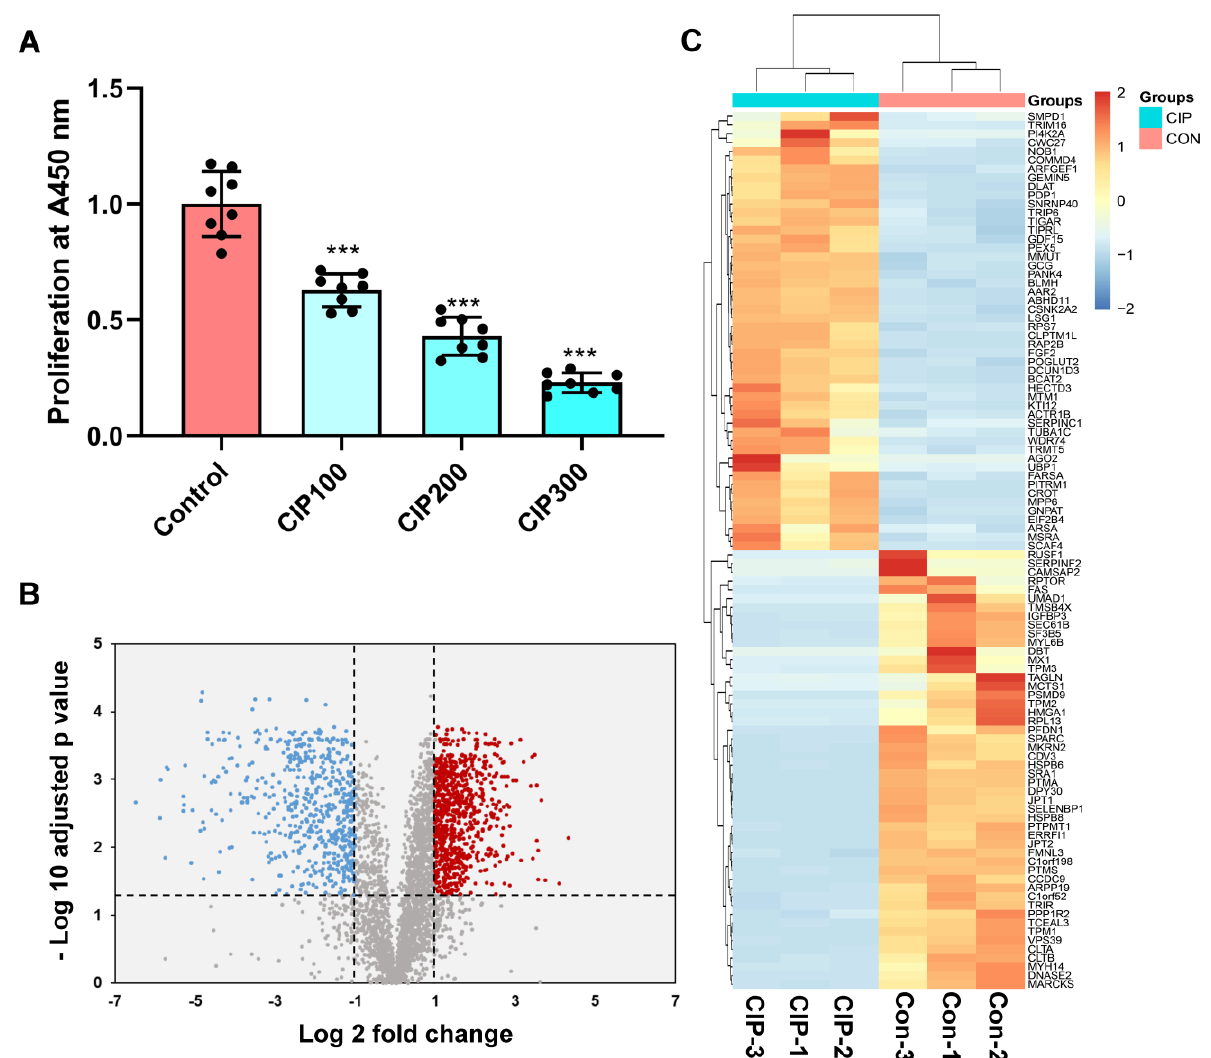
Figure 1. Identification of DEPs in CIP-stimulated VSMCs and cluster analysis. ( A ) CCK-8 results of VSMCs after CIP stimulation; ( B ) Volcano plot of DEPs; ( C ) Cluster analysis of the top 100 DEPs (50 upregulated, 50 downregulated). The symbols (***) represents p < 0.001 vs. control.